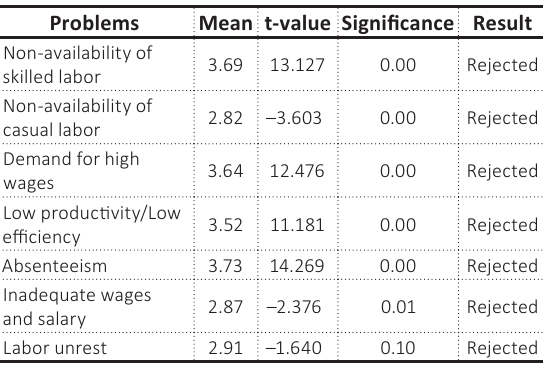
Table 5. Human resource challenges